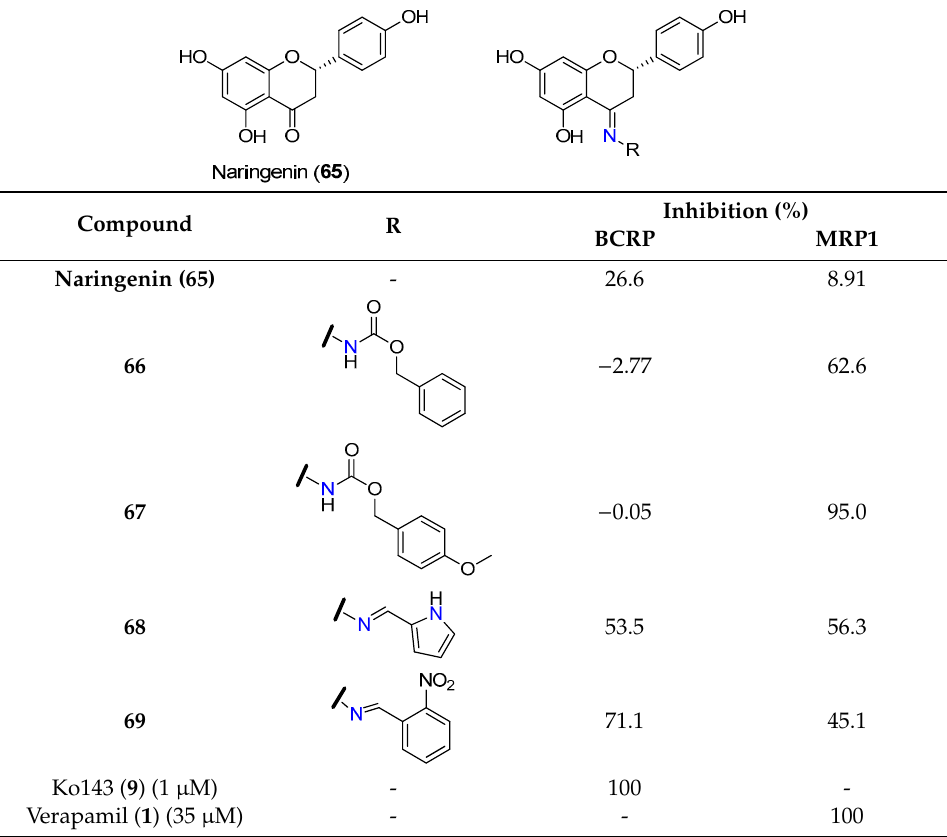
Table 5. Inhibitory activity of naringenin derivatives 66 – 69 in HEK293-MDR (BCRP) and BHK21 (MRP1) cells [104].